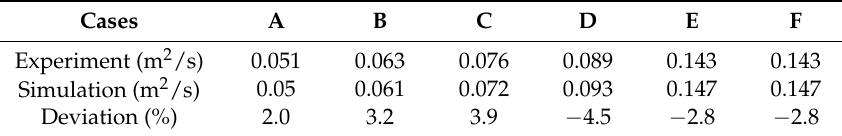
Figure 3. Variation in the flow rate of Case A. ( a ) Flow rate in the reservoir; ( b ) Flow rate through the reservoir gate. Table 2. SPH flow rates through reservoir gate in comparison with experimental data.